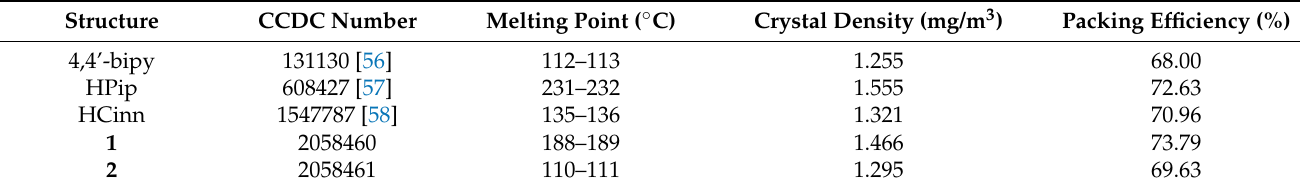
Table 5. Structural parameters and melting point values of 4,4’-bipy, HPip and HCinn crystal structures, and cocrystals 1 and 2